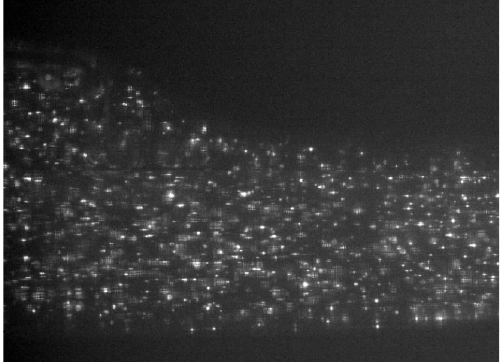
Figure 6. Raw PIV image from the measured object.